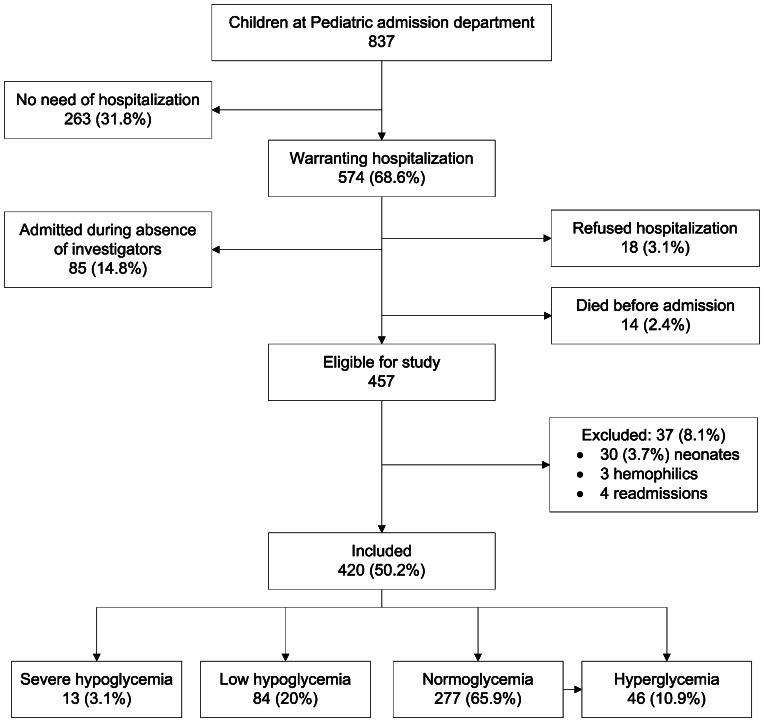
Enrolment flow chart.